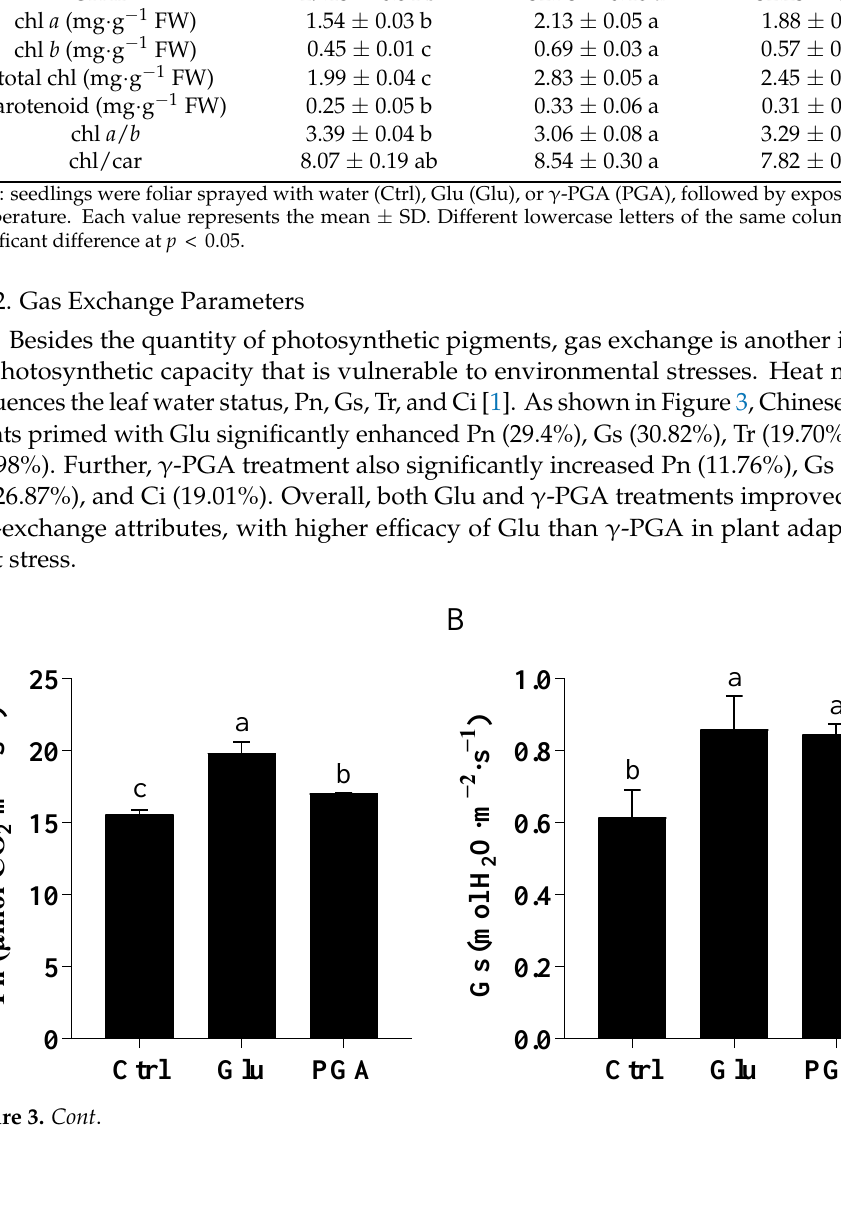
Table 3. Effects of Glu and γ -PGA on photosynthetic pigment of Chinese cabbage under heat stress. Pigment